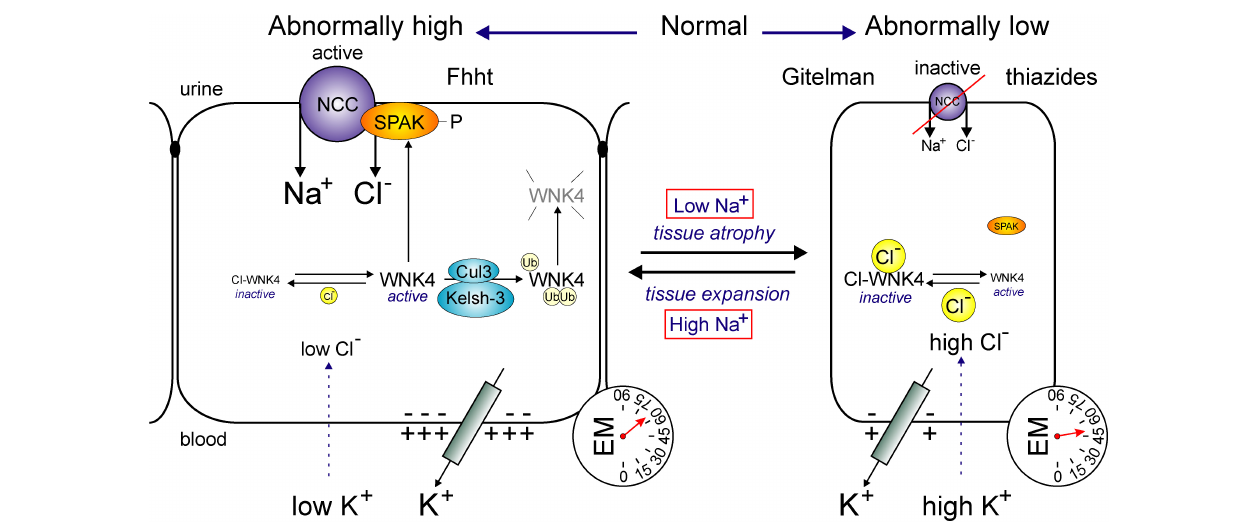
FIGURE 6 | Hypertrophy or atrophy of DCT segment as a function of Na + transport. Function of the NCC affects the size of the DCT segment. In conditions of abnormally high transport (left), such as Familial hyperkalemia and hypertension (Fhht, or Gordon syndrome) or low plasma K + , the DCT segment hypertrophies. Whereas, in conditions of low transport (right), such as Gitelman syndrome or chronic use of thiazides or high plasma K + , the DCT segment atrophies. The transport of Na + through NCC is regulated by the WNK4/SPAK cascade. WNK4 activity is modulated by intracellular Cl - levels which are sensitive to plasma K + . Low intracellular Cl - activates WNK4, SPAK and NCC, whereas high intracellular Cl - inhibits WNK4, SPAK, and NCC. DCT-mediated Fhht is due to either mutations in WNK4 or mutations in ubiquitin ligase protein complex Cullin-3 and Kelsh-3. In each case, expression of WNK4 is enhanced leading to increased SPAK and NCC